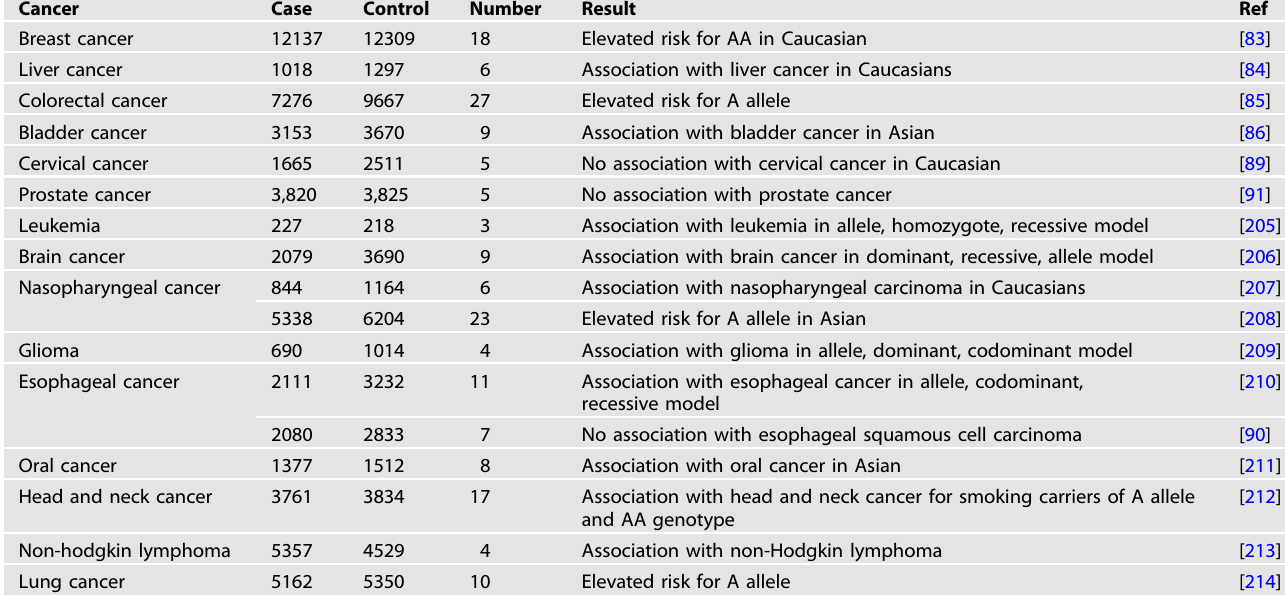
Table 1. The meta-analysis studies of CCND1 G870A mutation in cancers.